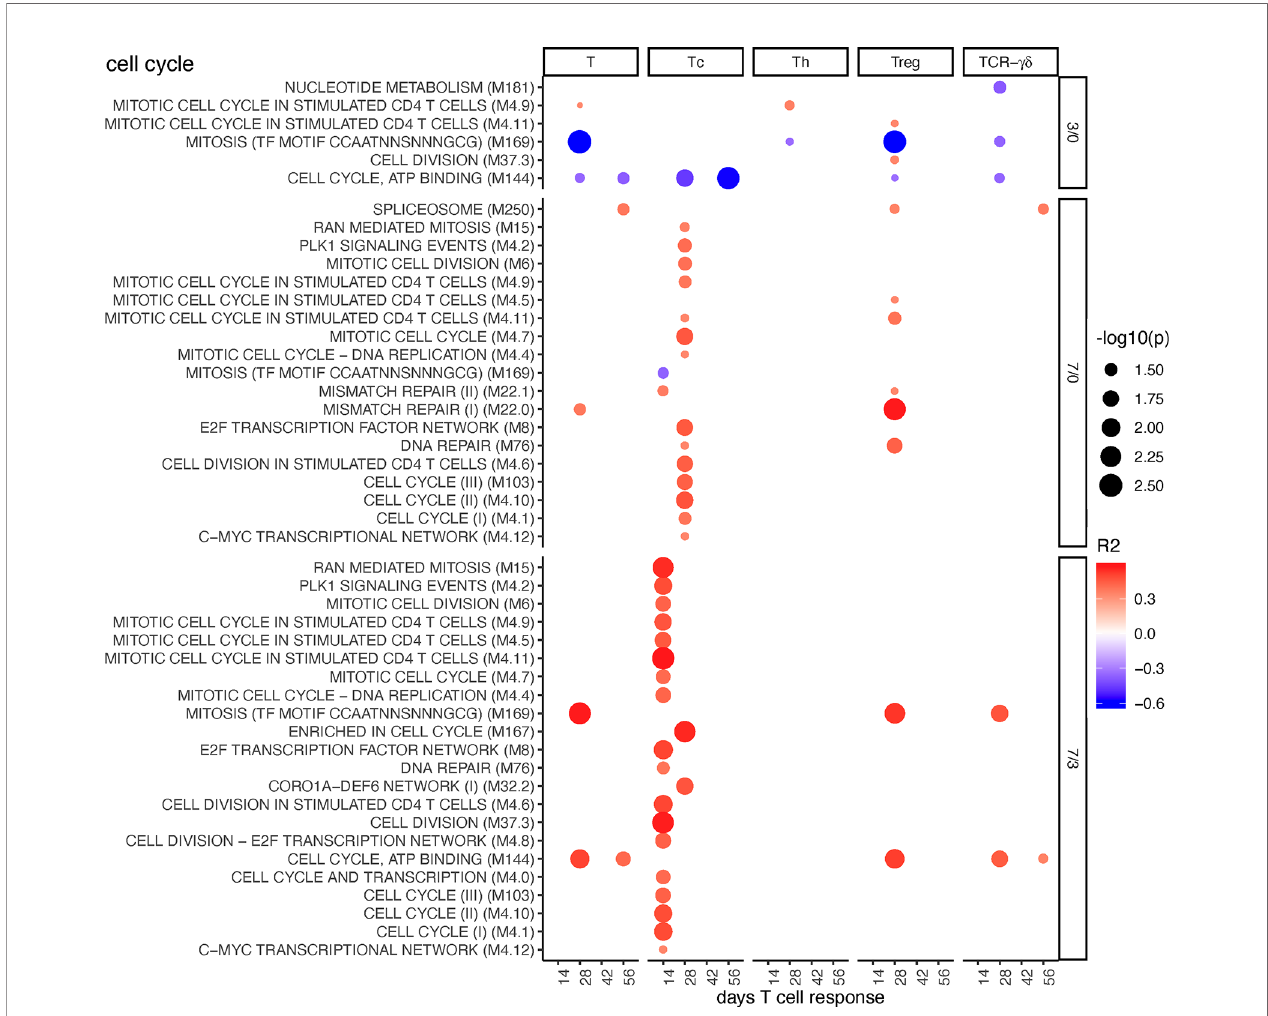
FIGURE 7 | Cell cycle BTM correlating with T-cell priming. Time-dependent single-sample enrichment scores for BTM were correlated with the proliferative recall response of total CD3 + T cells, Tc, Th, and TCR- gd T-cells measured at 14, 28, 42, and 56 days after LP or HP PRRSV-2 infection [x-axis, data from (15)]. R squared correlation coef fi cients for the BTM changes from D3/0, D7/0, and D7/3 are indicated by the color gradient (red for positive values, blue for negative values). Increased circle sizes indicate smaller p values (cutoff <